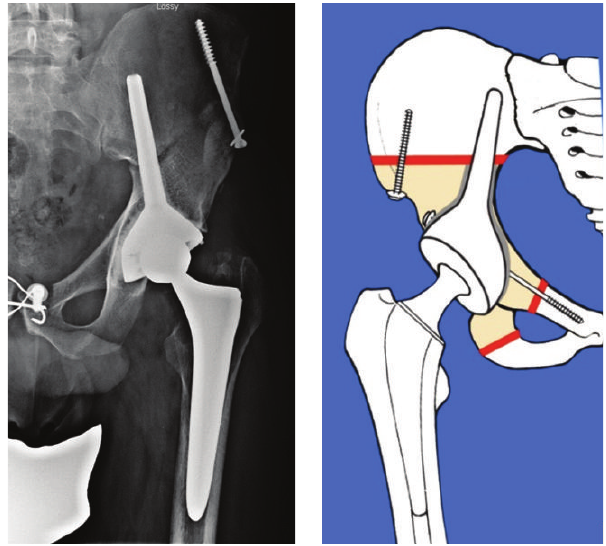
Figure 4: Reconstruction with CISP (P2 resection).